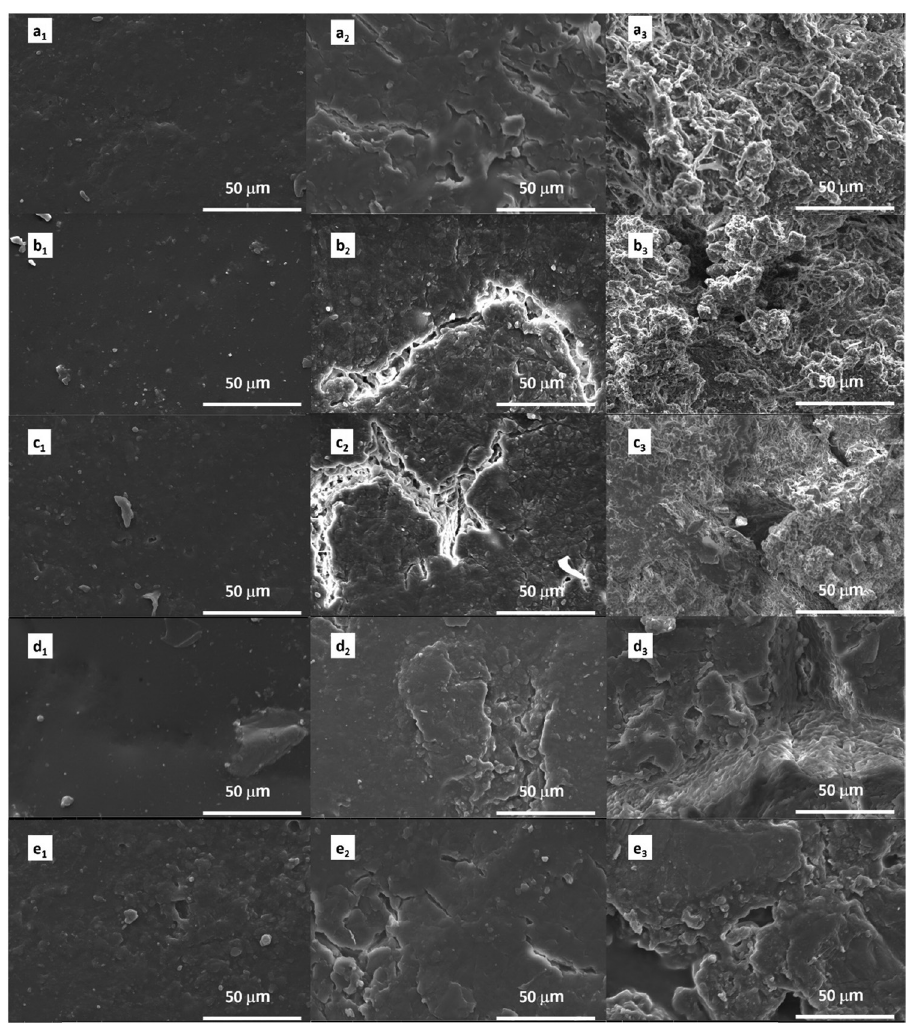
Figure 6: SEM micrographs of PBA m T80 ( a 1 – a 3 ) , PBA m T75 ( b 1 – b 3 ) , PBA m T70 ( c 1 – c 3 ) , PBA m T60 ( d 1 – d 3 ) , and PBA m T55 ( e 1 – e 3 ) , during enzy - matic degradation at several times; ( a 1 – e 1 ) 0 days, ( a 2 – e 2 ) 2 weeks, and ( a 3 – e 3 ) 6